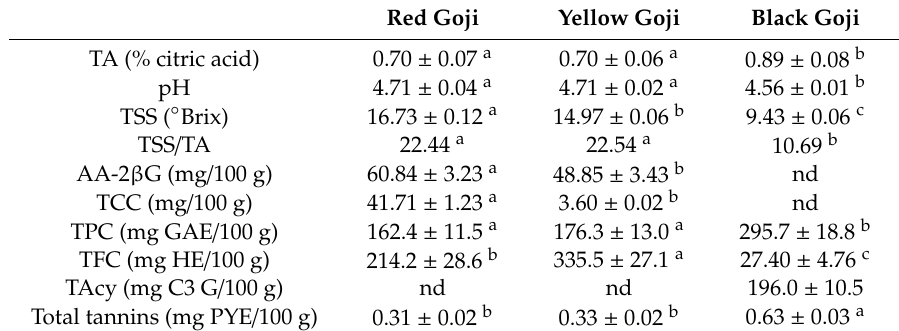
Table 5. Titratable acidity (TA), pH, total soluble solids (TSS), TSS / TA and bioactive compounds in analyzed goji berry fruits.